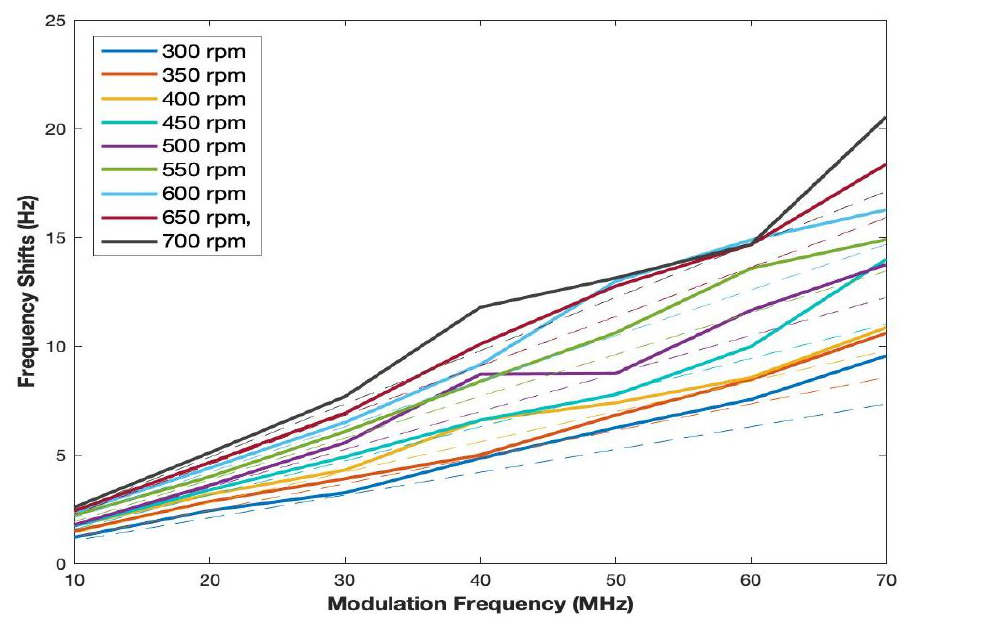
Figure 12. Measurements of frequency shifts for all RPMs up to the modulation frequency of 70 MHz (solid lines are measured values and dashed lines are real velocity generated by the experiment